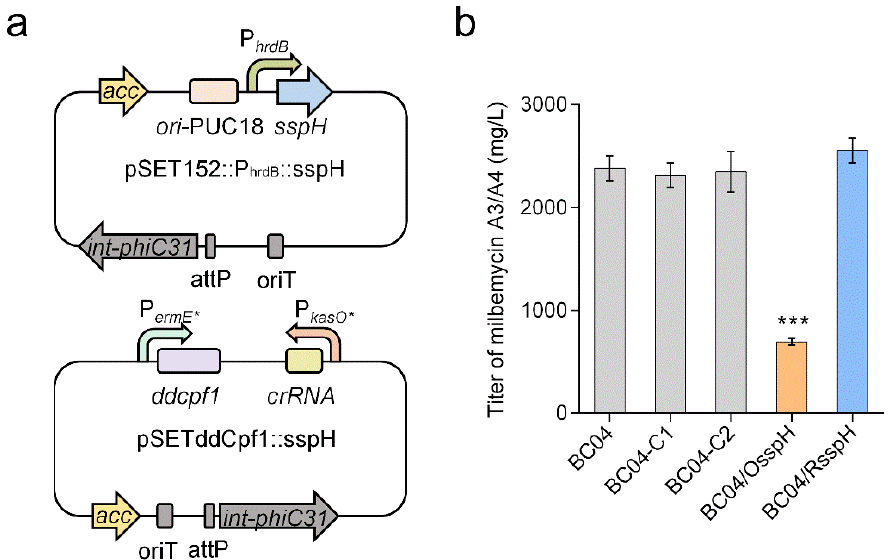
Figure 2. Effects of sspH overexpression and repression on milbemycin production. ( a ) Schematic diagrams of sspH overexpression and repression plasmids. The hrdB promoter P hrdB was used to drive the expression of sspH . Two strong promoters, P ermE* and P kasO* , were used to drive the expression of ddcpf1 and crRNA , respectively. ( b ) Titer of milbemycin A3/A4 in strains BC04, BC04-C1, BC04-C2, BC04/OsspH and BC04/RsspH. The milbemycin titer was determined after fermentation for 9 days. BC04, the parental strain; BC04-C1, BC04 with pSET152::P hrdB ; BC04-C2, BC04 with pSETddCpf1; BC04/OsspH, sspH overexpression strain; BC04/RsspH, sspH repression strain. Data are presented as the averages of three independent experiments conducted in triplicate. Error bars show standard deviations from three replicates. p -values were determined by Student’s t -test. *** p <